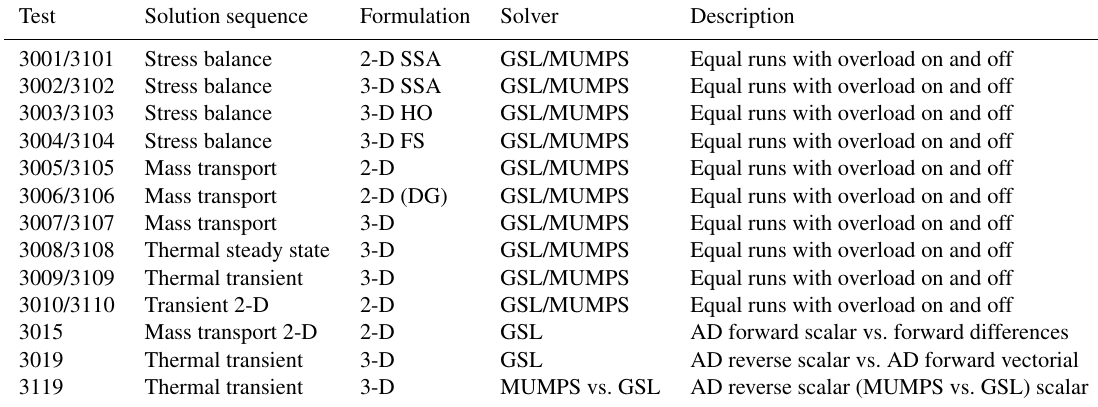
Table 3. ISSM AD validation suite integrated within Jenkins for continuous integration and delivery (Smart, 2011). Tests 3001 to 3010 and 3101 to 3110 test the repeatability of forward runs with and without ADOL-C compiled, but with no AD drivers specifically called. The forward runs involved are the standard stress balance, mass transport, and thermal solutions, with 2-D SSA (shelfy-stream approximation MacAyeal, 1989), 3-D SSA, 3-D HO (higher-order, Blatter, 1995; Pattyn, 1996), 3-D full-Stokes (Stokes, 1845), and DG (discontinuous- Galerkin) formulations. Test 3015 tests the AD GSL capability by comparing the AD forward scalar mode (where we compute the gradient of ice volume with respect to ice thickness at one vertex of the mesh) against a simple forward differences computation on the same gradient. Test 3019 validates the AD GSL capability in reverse scalar mode (where we compute ice volume gradient with respect to thickness at all vertices of the mesh) vs. the forward vectorial mode. Both gradients should be identical. Finally, test3119 validates the parallel capabilities (AD MUMPS) by comparing reverse scalar computations with GSL and